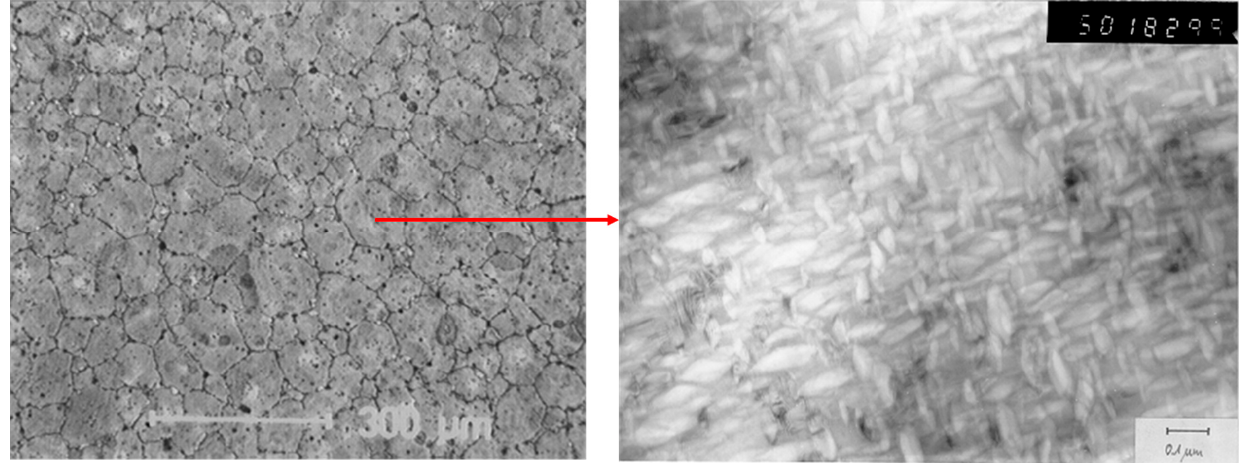
Figure 9. Microstructure of Mg-PSZ ( left ) and its tetragonal precipitates within one grain ( right ).